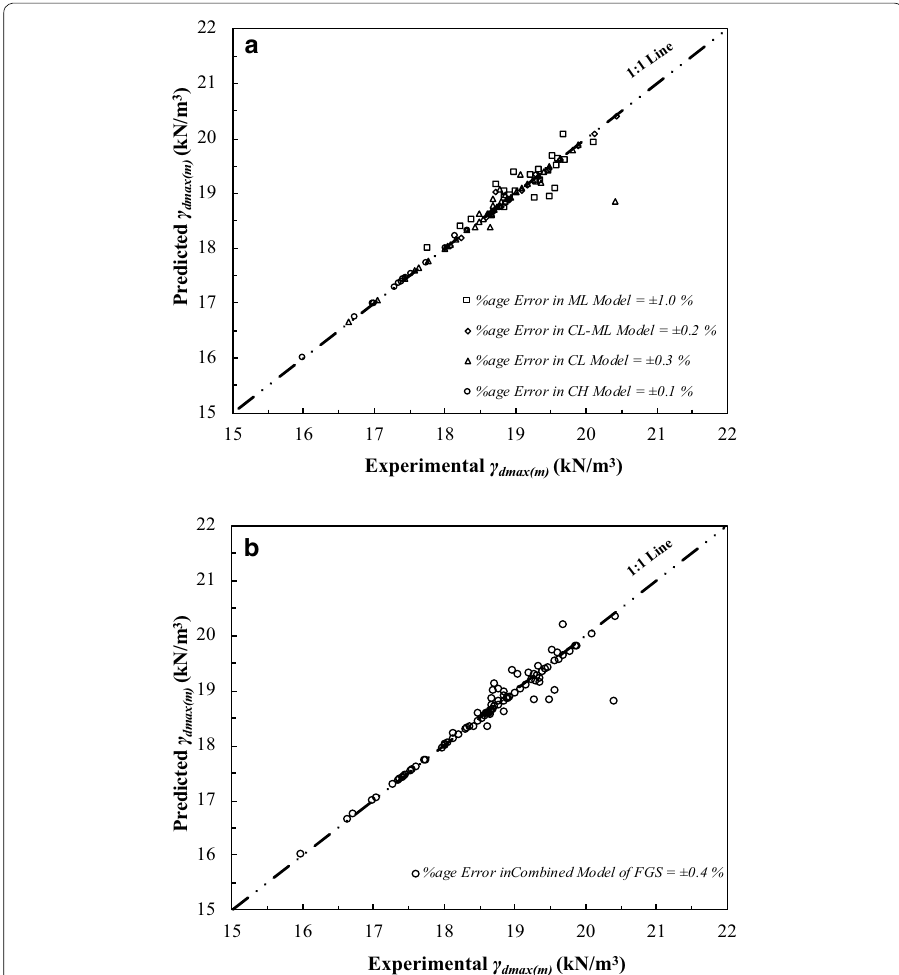
Fig. 10 Experimental versus predicted values of γ dmax(m) based on data used to develop models ( a ) by using models developed for different types of fine-grained soils (FGS) ( b ) by using combined model of